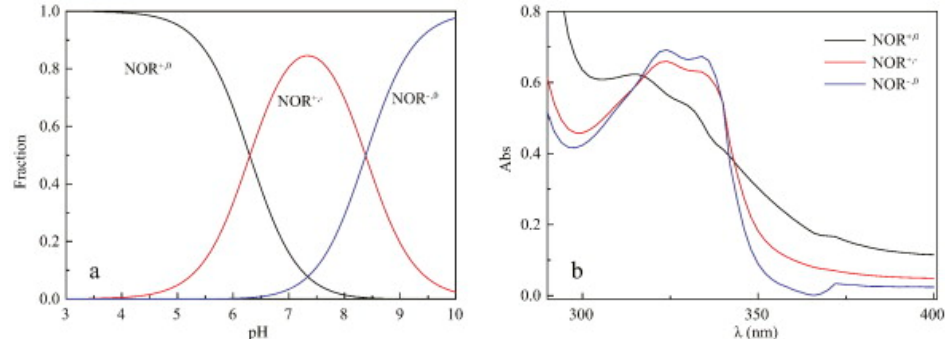
Figure 2. Fraction distribution ( a ) and UV-vis absorbance spectra ( b ) of the three dissociated species of norfloxacin (NOR). Reprinted from Liang et al. [33] Copyright (2015), with permission from